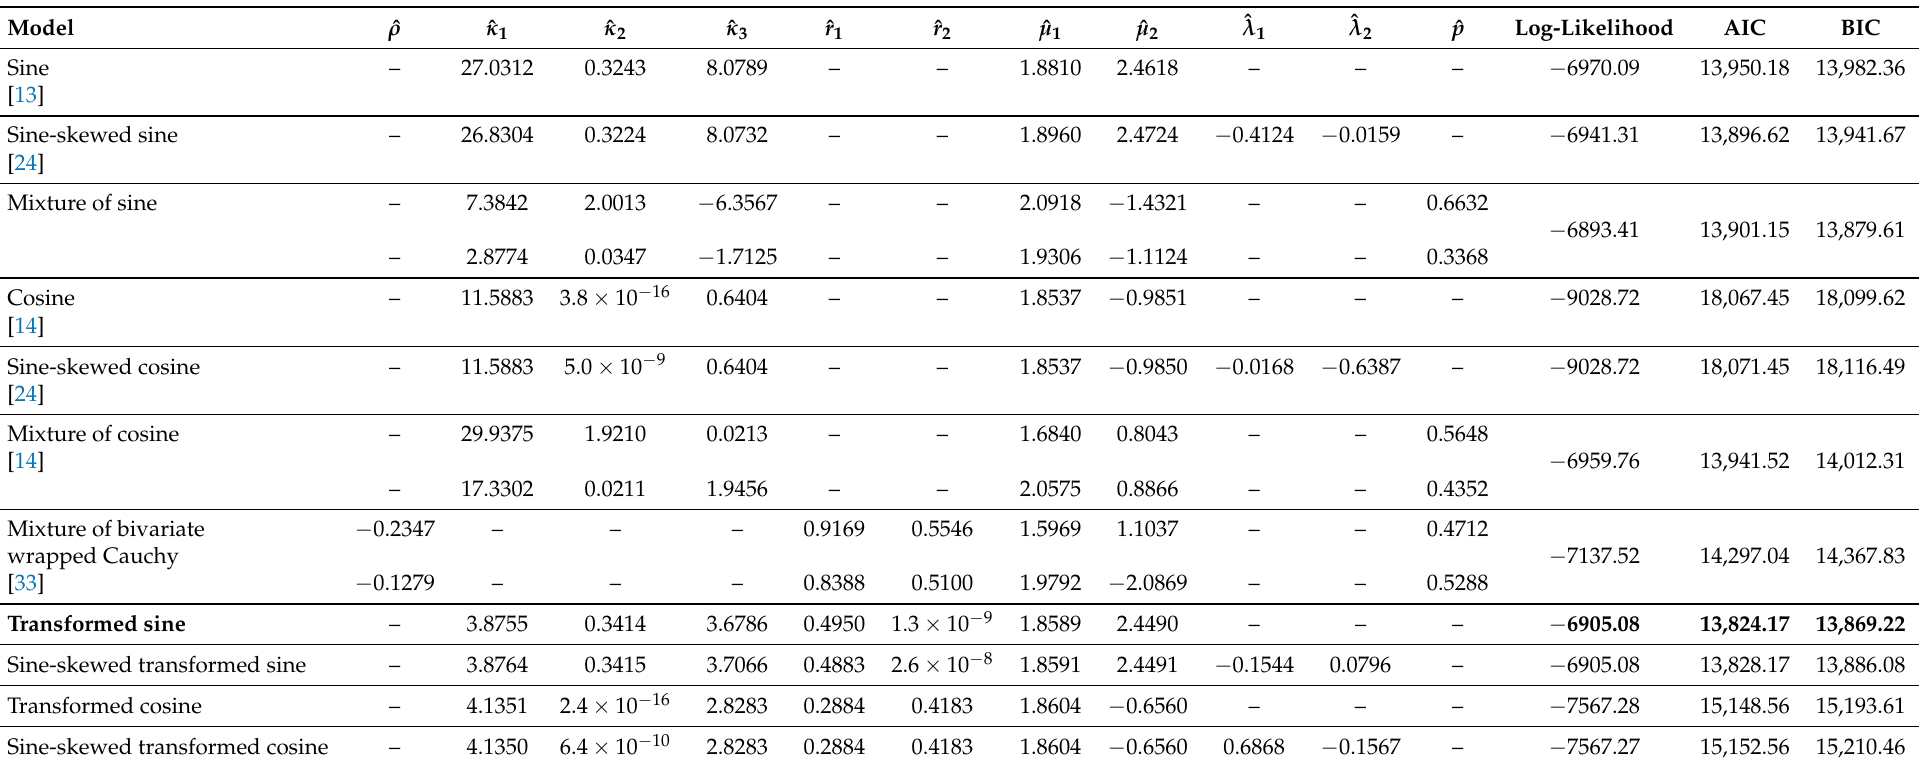
Table 2. Maximum likelihood estimates and corresponding log-likelihood, AIC, and BIC for SCOP.3 ( n =